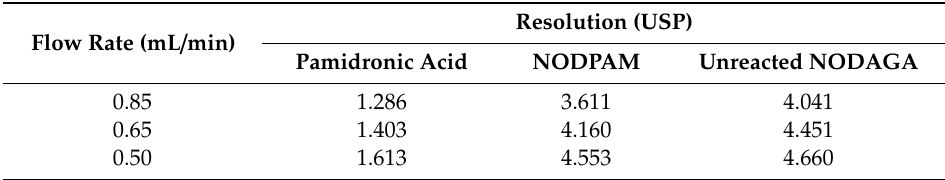
Table 4. Resolution of the three peaks (pamidronic acid, NODPAM, unreacted NODAGA) from the unseparated NODPAM mixture at di ff erent flow rates.